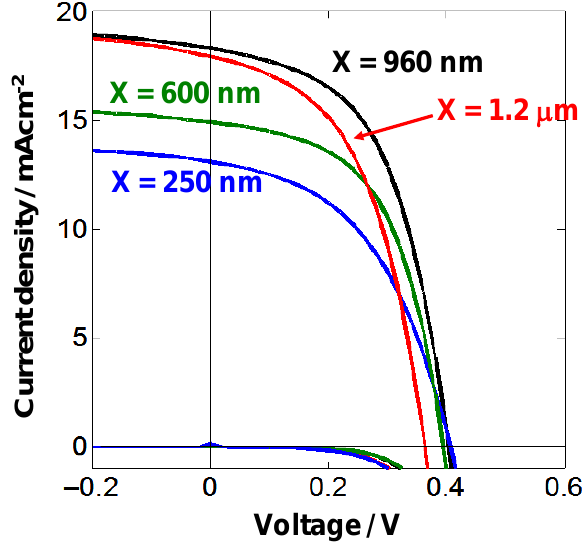
Figure 7. Current-voltage (J-V) characteristics for p-i-n cells with i -layer thicknesses ( X ) of 250 nm, 600 nm, 960 nm, and 1.2 µm. Cell parameters ( X = 960 nm); J V : 0.40 V, FF: 0.53, Efficiency: 5.3%. The simulated light intensity transmitted through oc the ITO glass substrate is 74.2 mWcm −2